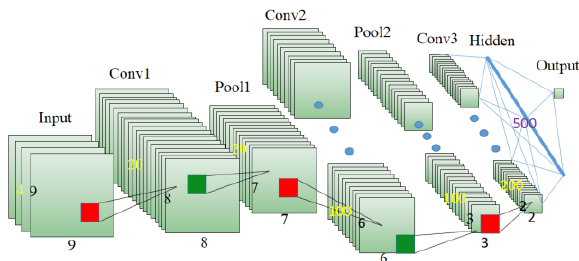
Figure 2. The structure of the proposed CNN model.